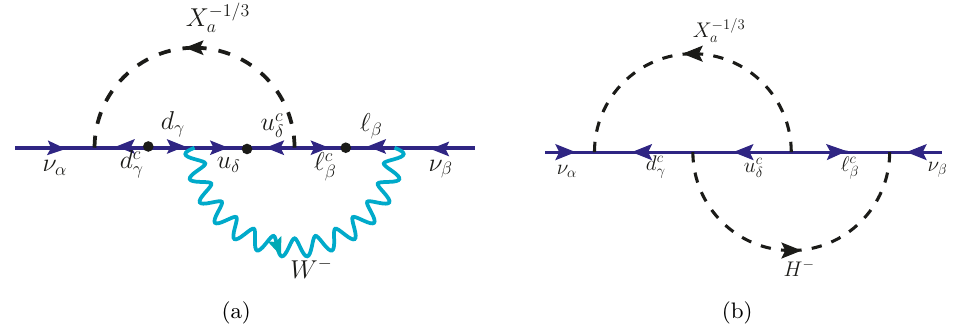
Figure 45 . Two-loop diagrams contributing to neutrino mass generation in the model of ref. [33]. The model realizes operator